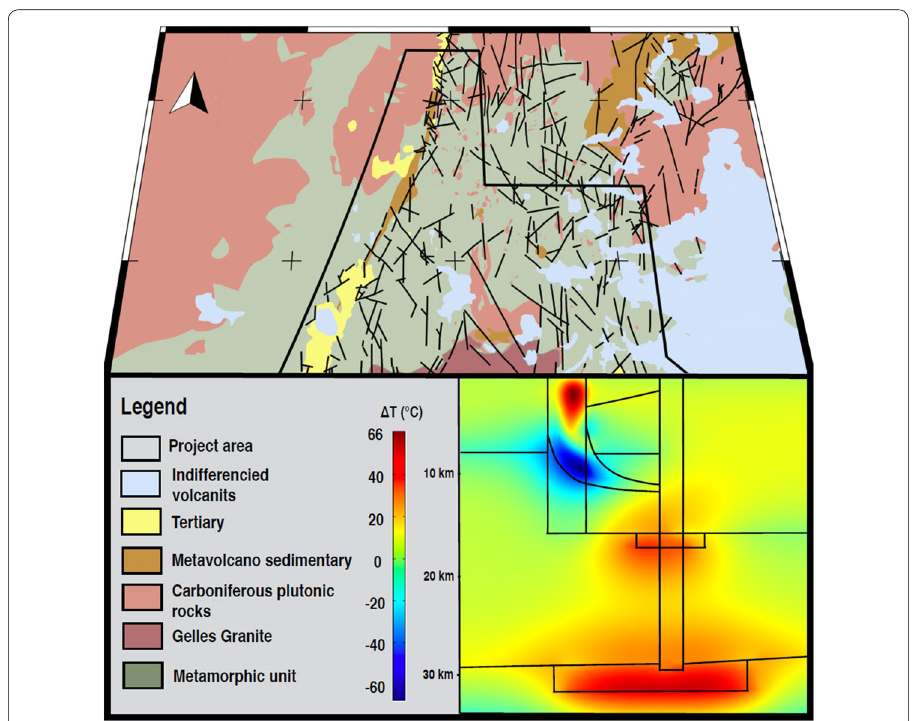
Fig. 15 Numerical simulation results for a maximum permeability imposed on the Pontgibaud fault zone of 1.6 10 − 14 m − ×